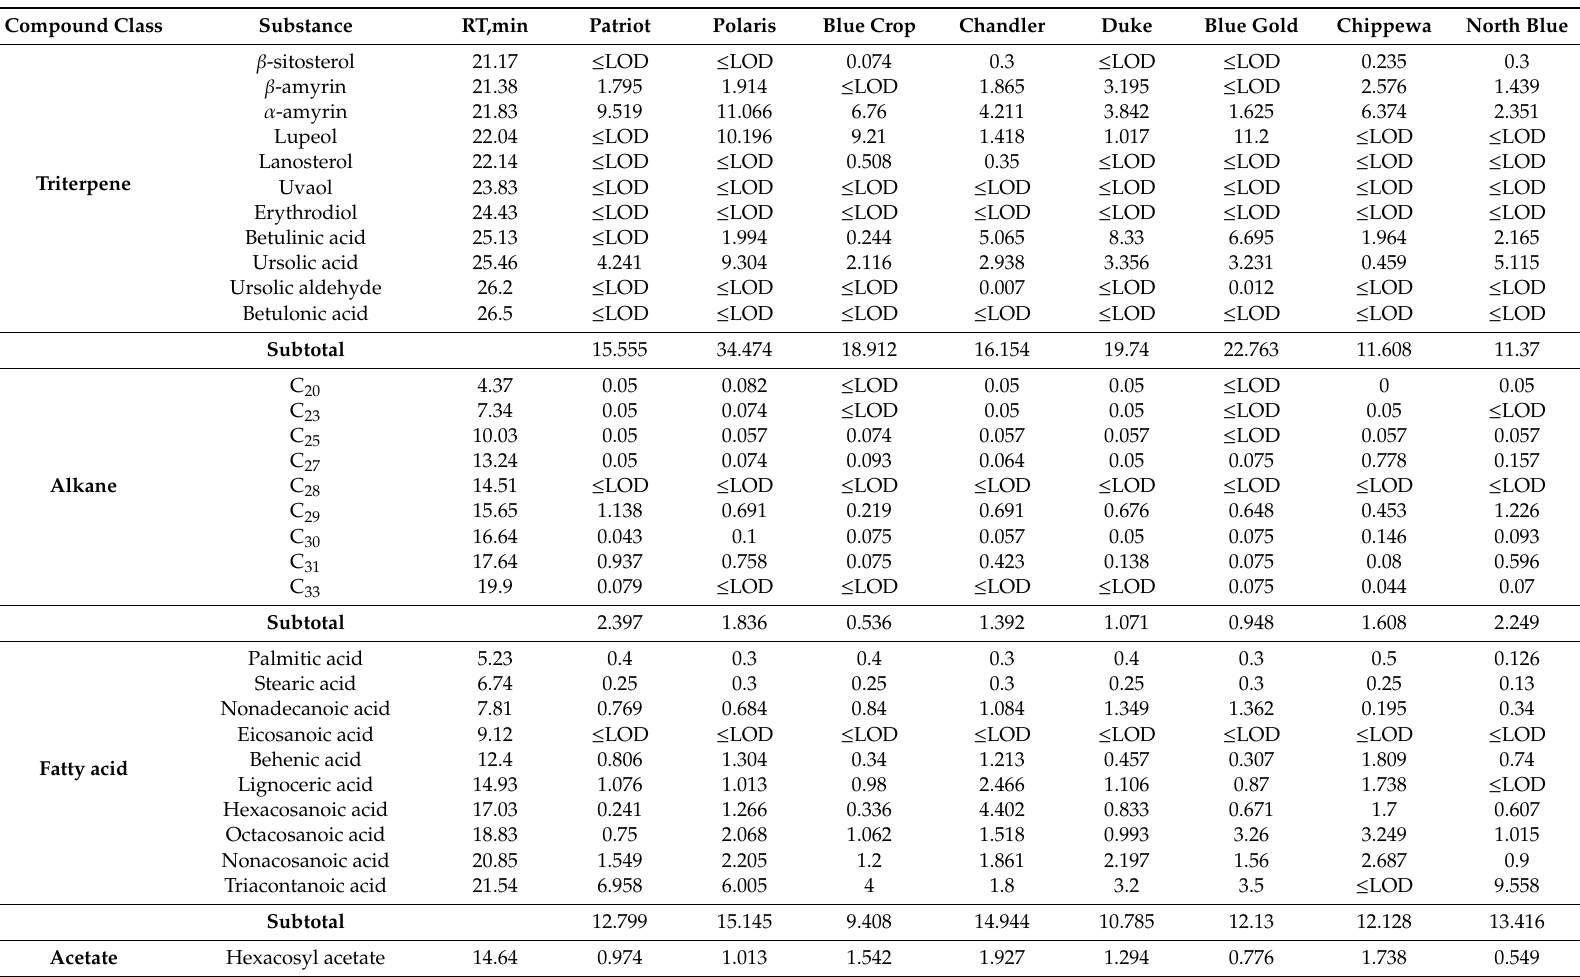
Table A2. Identified compounds found as part of cuticular wax of studied blueberry varieties. ≤ LOD—concentration of substance was less than the limit of detection. Concentration of each substance expressed as g 100 g − 1 of berry cuticular wax extract. Standard error of measurements was determined to be 3–6% (n =